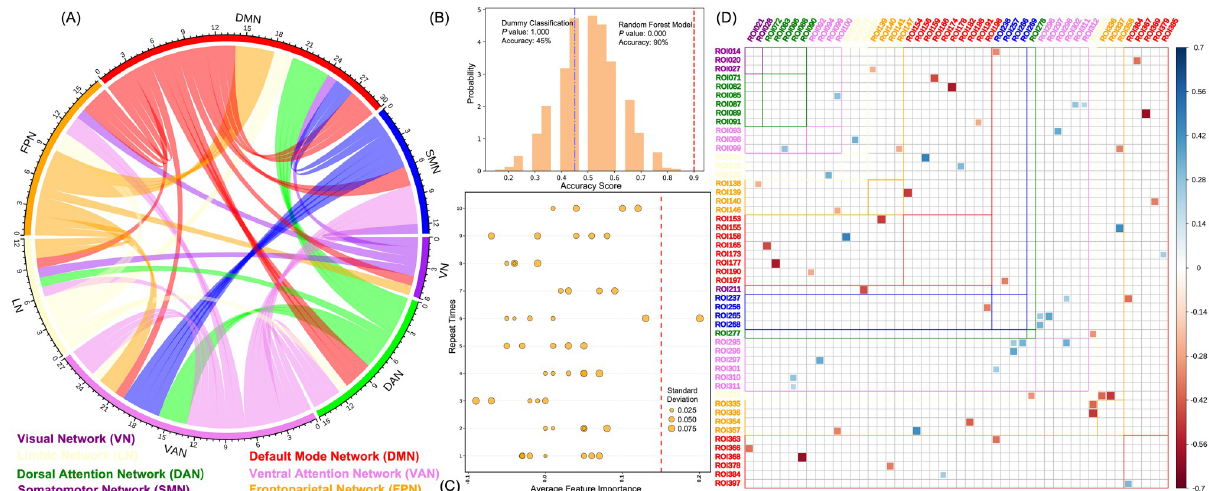
Fig 3. Model performance and feature selection. (A) Flow diagram of 60 features filtered by the linear support vector classification. The different colors represent different networks. (B) The result of 5,000 times permutation test in model performance evaluation. The red line is the result of the random forest model, and the blue line is the dummy classification. (C) The result of 5,000 times permutation test, which was repeated 10 times, in feature importance ranking. The size of the circle represents the standard deviation score, and the red line is the importance coefficient = 0.15. (D) The correlation diagram of 60 features filtered by the linear support vector classification. The different colors in ROI represent different networks.